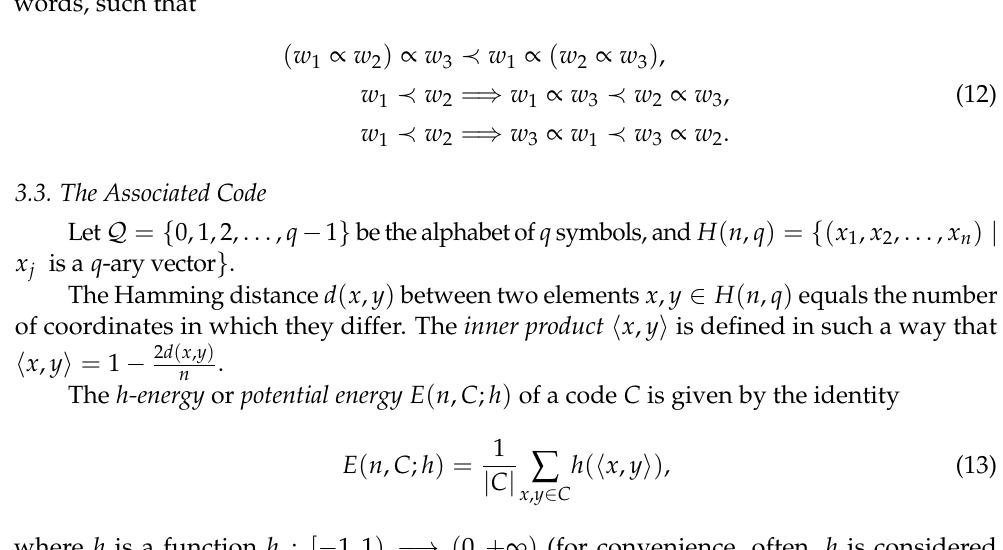
Figure 7. The grove consisting of binary trees associated with 3-tile snake graphs.